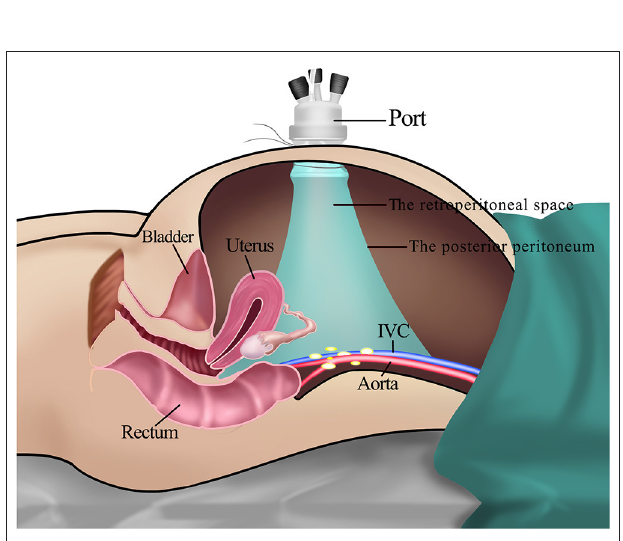
FIGURE 5 | The establishment of the retroperitoneal space. IVC, inferior vena